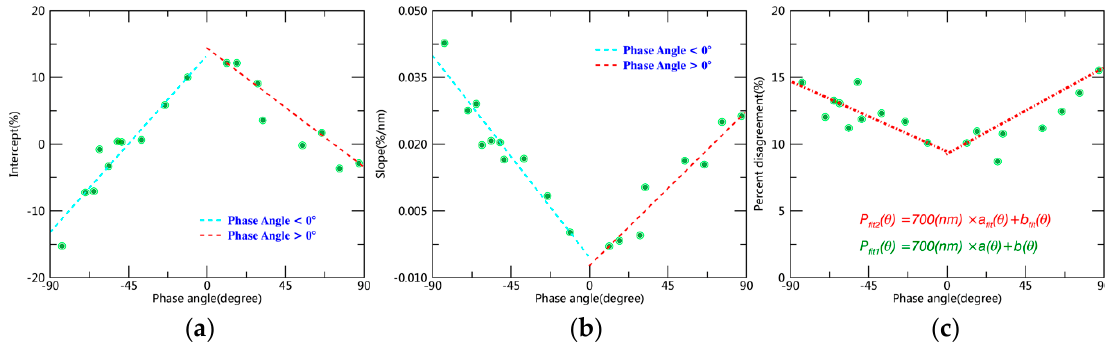
Figure 17. Linear trend of the percent disagreement with phase angle. ( a ) Intercept of the percent disagreement. ( b ) Slope of the percent disagreement. ( c ) Percent disagreement from linear trends. For each observation, the slopes a ( θ ) and b ( θ ) of the percent disagreement ranging from 400 to 700 nm are shown in green scatter, respectively. The fitting lines before and after full moon respectively are cyan and red dashed lines. In Figure 17c, the fitting di ff erence from Equation (18) between measurement and ROLO model is in green scatter, and the fitting di ff erence from Equation (21) at 700 nm is indicated via the red line.